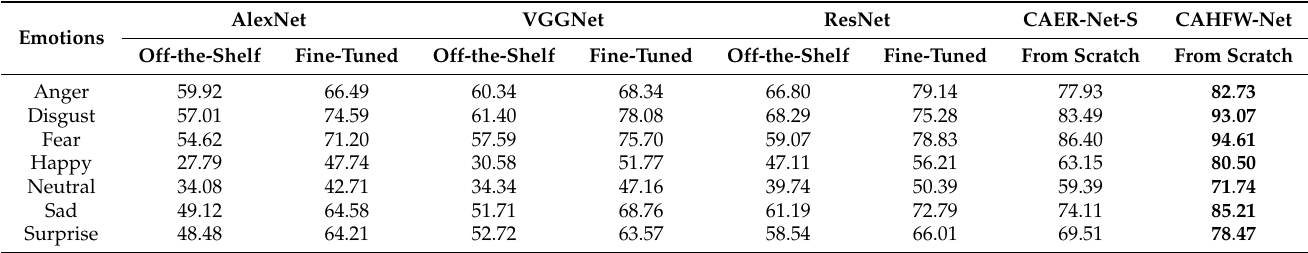
Figure 8. Comparison of emotion prediction performance with baseline methods on each category in the CAER-S benchmark. O and F denote off-the-shelf and fine-tuned versions, respectively. Table 3. Accuracy (%) of CAHFW-Net and baseline methods on each emotion category in the CAER-S